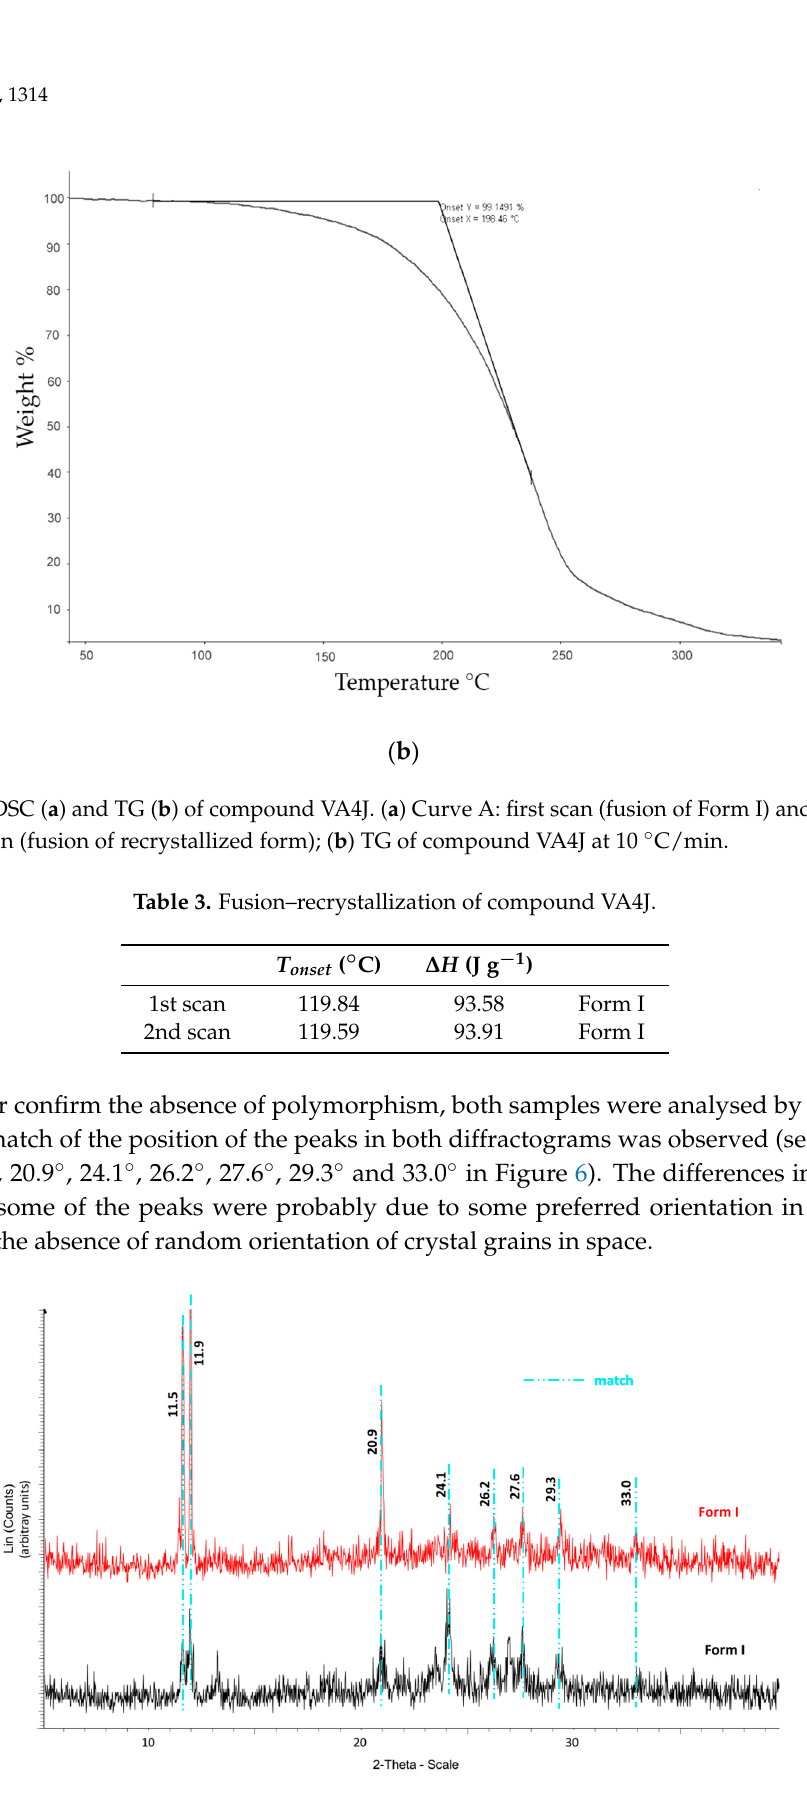
Figure 6 . X-ray diffractograms of the original form of VA4J (in black) and those obtained after successive cycles of melting–recrystallization (in red).